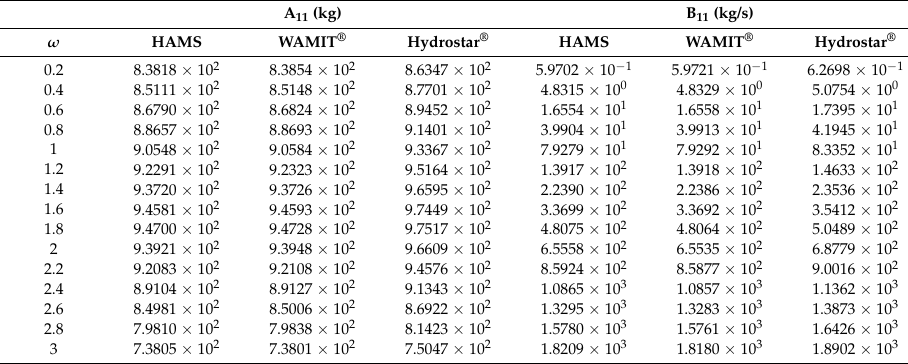
Table 2. Hydrostatic quantities of the truncated circular cylinder calculated by HAMS, WAMIT ® , and Hydrostar ® , under a finite water depth h = 1.0